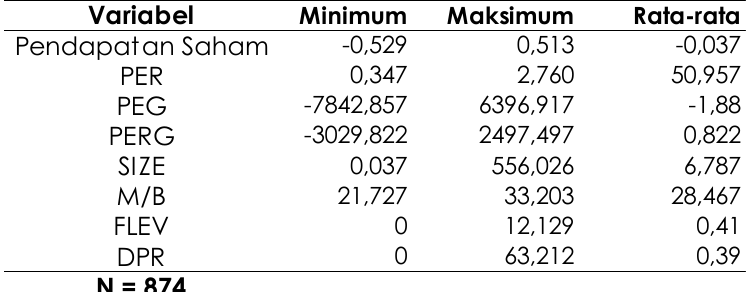
Analisis Model dan Pengujian